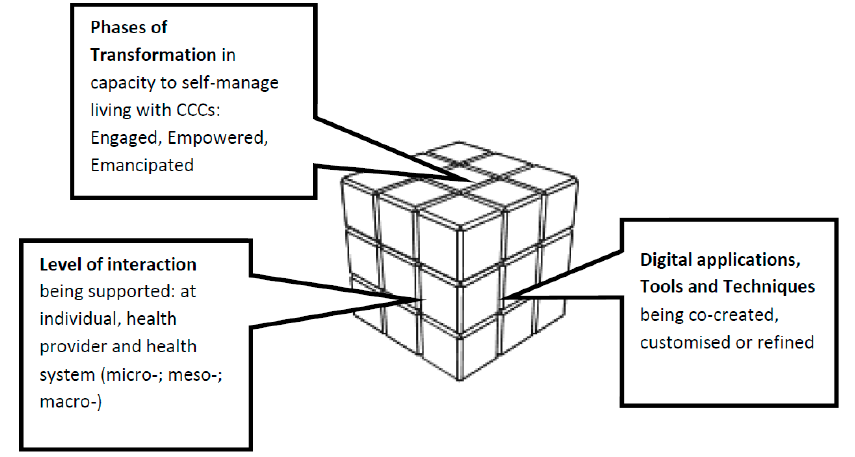
Figure 2. Considerations for the co-production of digital health behaviour change initiatives.